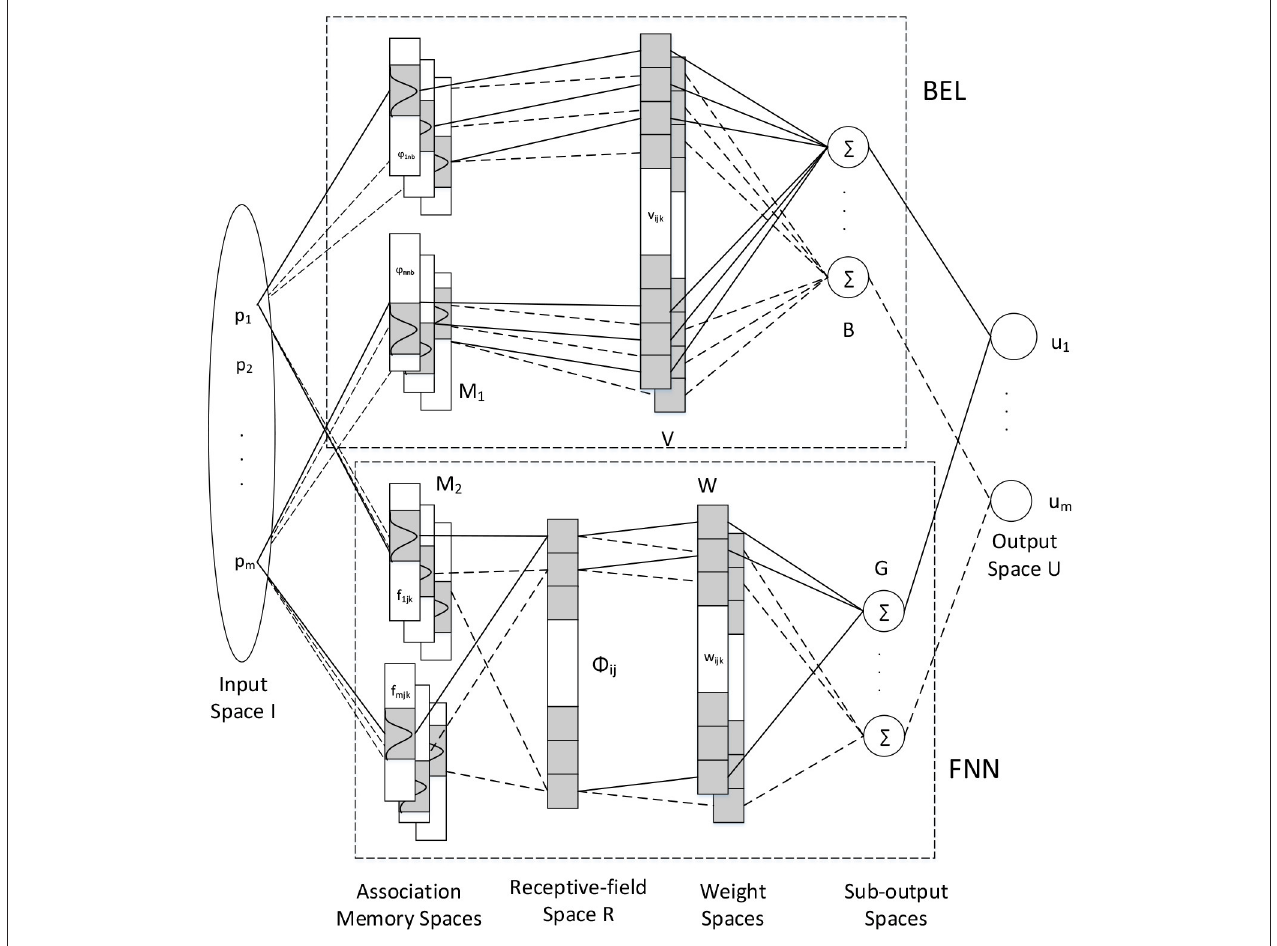
FIGURE 1 | The configuration of